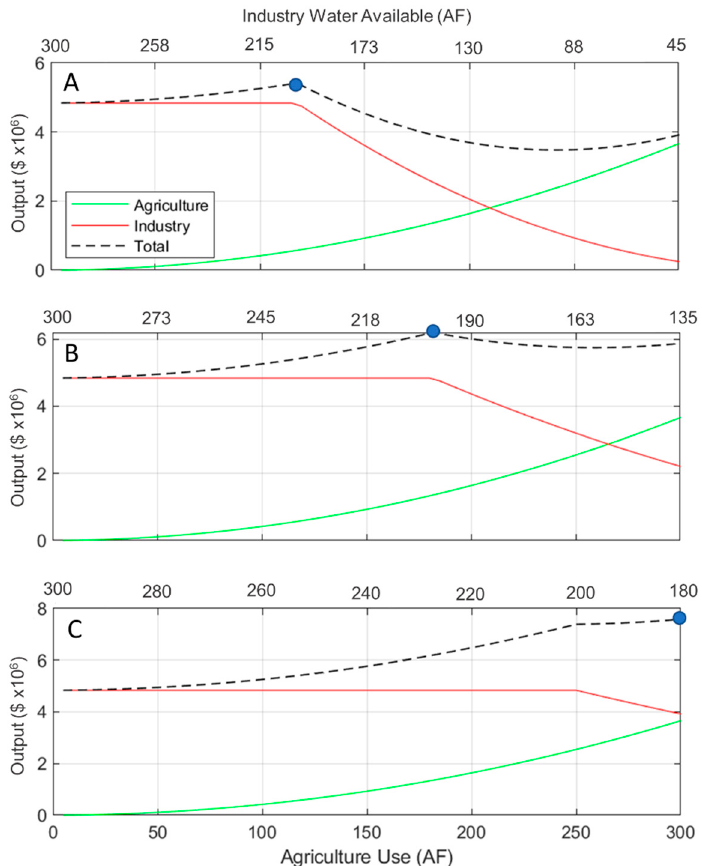
Figure 4. Comparison of optimal water allocation for 300 AF of total water, for upstream (agricultural) return flows of ( A ) 15%, ( B ) 45%, and ( C ) 60%. Maximum GRP (blue dots) increases, and optimal allocation shifts towards agricultural use, as return flow fraction increases. Upper x -axis label shows available water remaining for industrial use following agricultural extraction and return flows in each scenario. Bottom x -axis labels are the same for all scenarios.